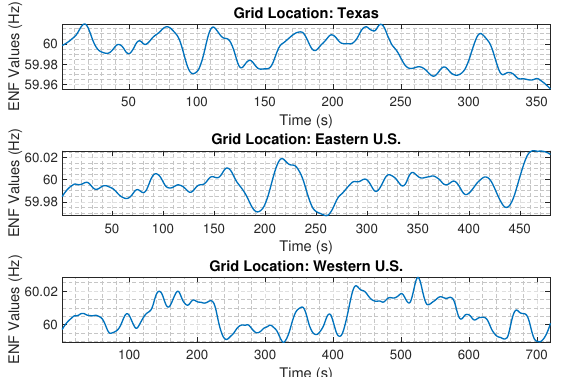
Figure 1. Sample electrical network frequency (ENF) sequences extracted from power recordings from different 60 Hz grid